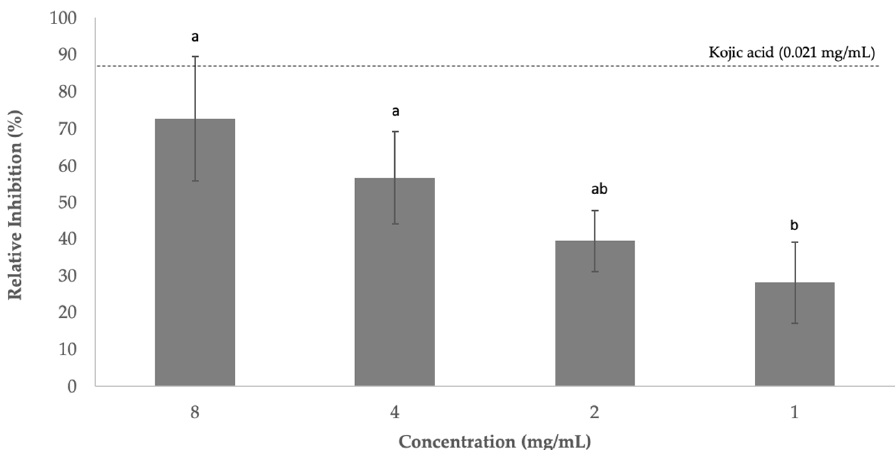
Figure 3. Percentage of tyrosinase activity inhibited (means ± SD) when tested with sugarcane straw extract. Extracts were previously diluted in water and tested at 8, 4, 2, and 1 mg/mL. Positive tyrosinase control used was kojic acid. Values presented are the mean ± standard deviation. a,b Different letters mean statistically significant differences were obtained ( p < 0.05).